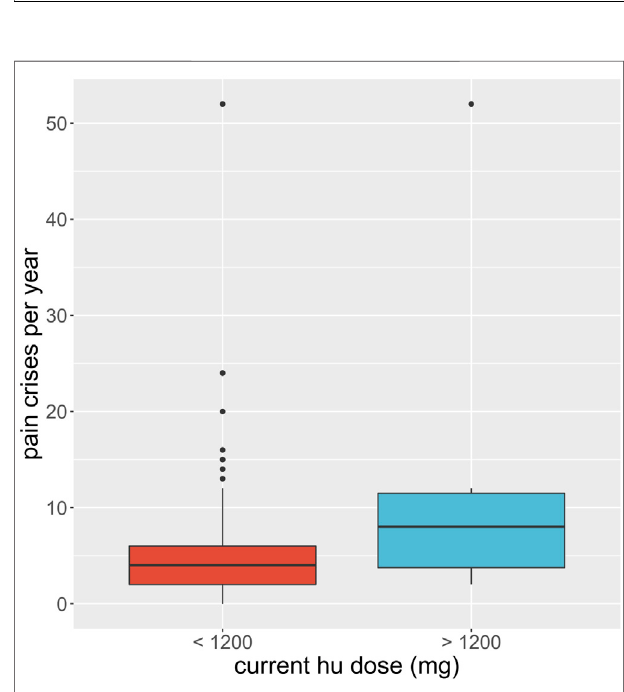
FIGURE 5 | Boxplot of the average recalled number of painful crises a participant experiences per year (y-axis) is compared for participants on regularhydroxyurea(hu)doses,lessthan1200 mgperweek(red),tothoseon exceptionally high doses, more than or equal to 1200 mg per week (blue). Black dots show the outlying participant